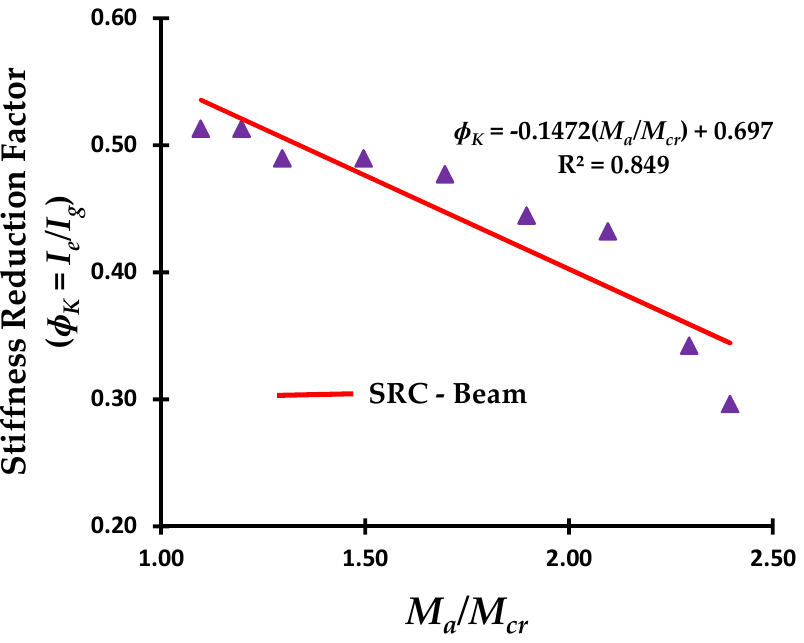
Forests 2020 , 11 , x FOR PEER REVIEW Figure 26. The relationship of the sti ff ness reduction factor ( φ K ) and the M a / M cr of the SRC beam. Figure 26. The relationship of the stiffness reduction factor ( ɸ K ) and the M a / M cr of the SRC beam.